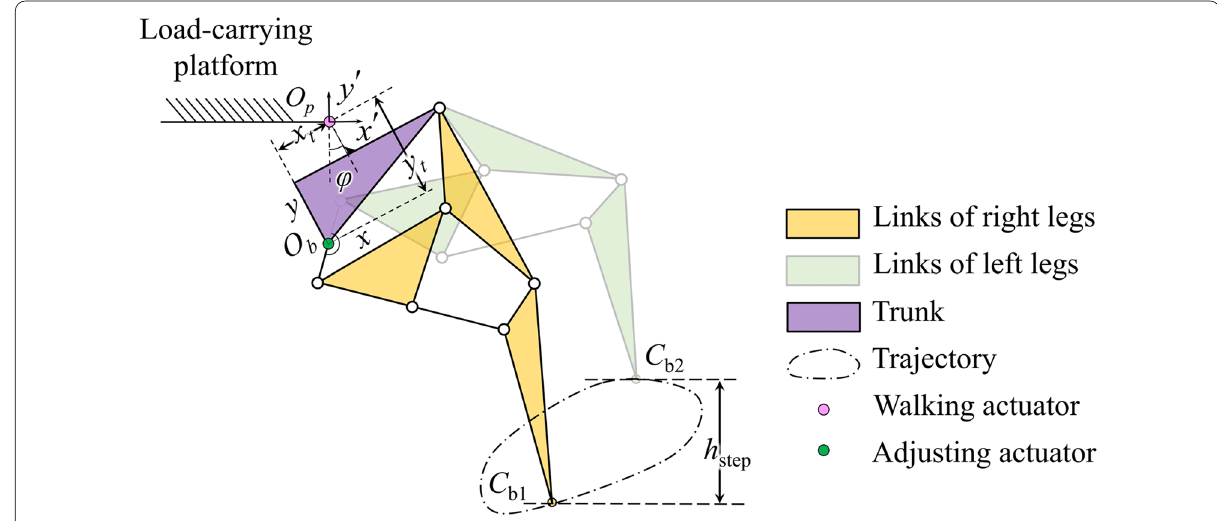
Figure 3 B‑LUAP configuration